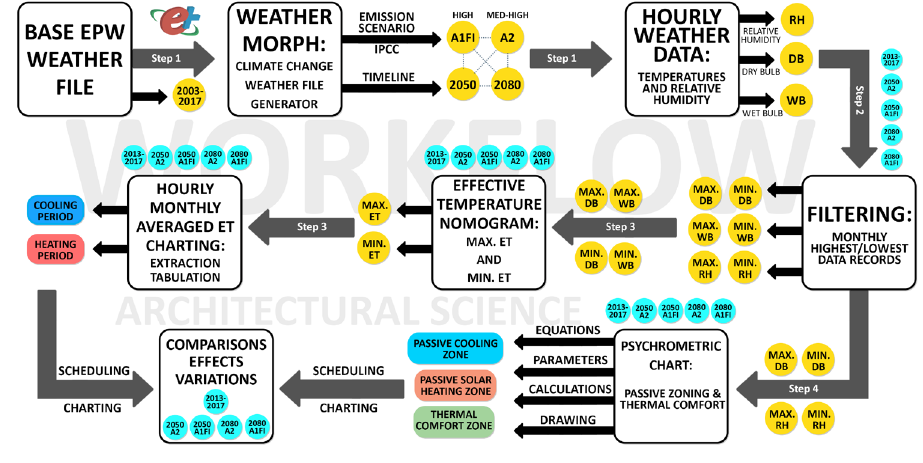
Fig. 3. Methodological Workflow